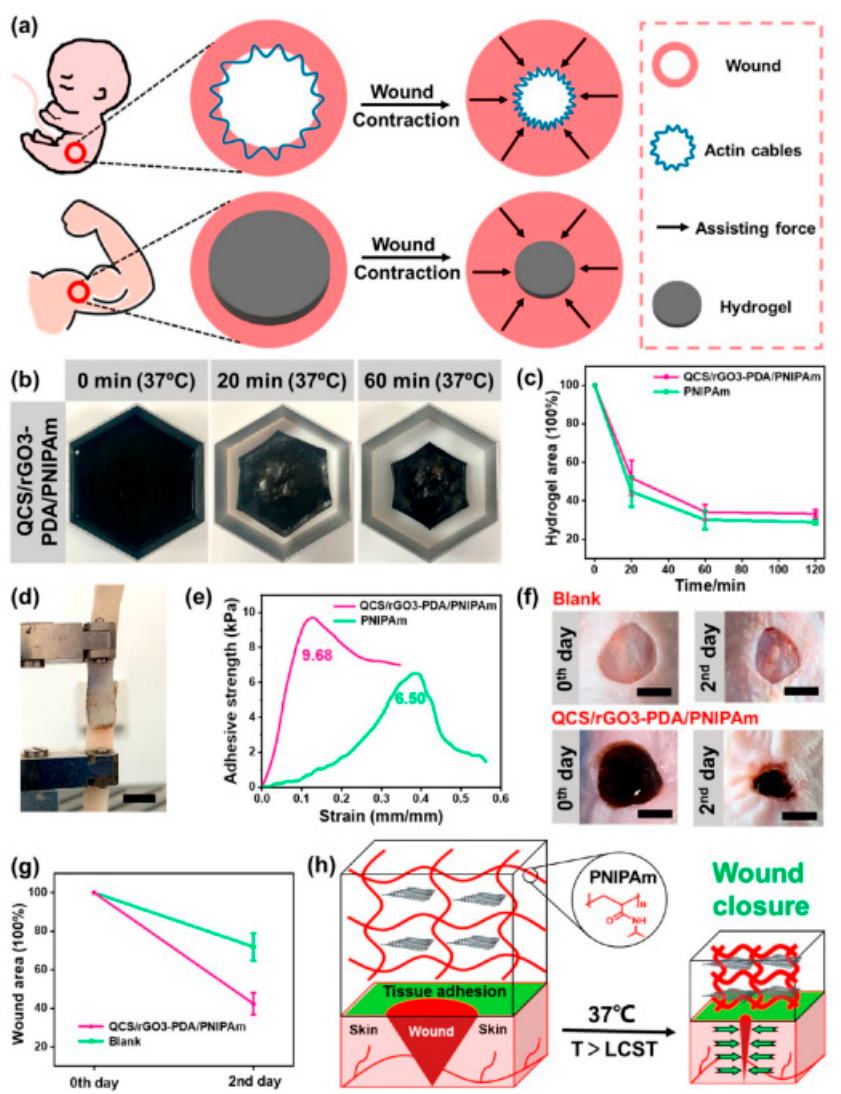
Figure 13. ( a ) Illustration of wound closure process of PNIPAM-ECH wound dressing. ( b ) Pictures of shrunk behavior of PNIPAM-ECH at 37 °C. ( c ) Change of hydrogel area of PNIPAM-ECH at 37 °C. ( d ) Picture of PNIPAM-ECH for adhesive strength testing. ( e ) Adhesive strength of PNIPAM-ECH. ( f ) Wound closure pictures of PNIPAM-ECH hydrogel group and blank group. ( g ) Wound area curves of PNIPAM-ECH hydrogel group and blank group. ( h ) Illustration of wound closure process of wound closure. Copy right from Ref. [89] ACS publications.